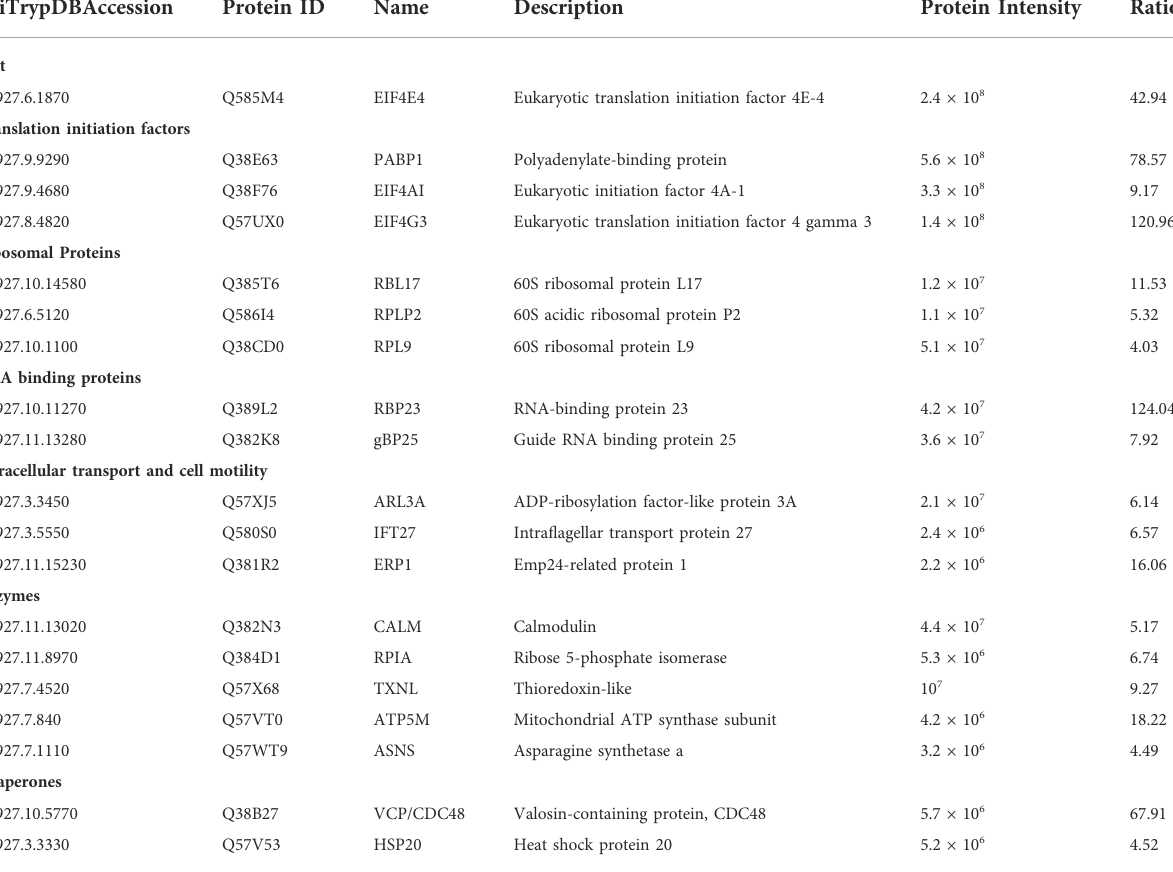
TABLE 3 Most enriched proteins co-precipitated with the eYFP-tagged EIF4E4 in Trypanosoma brucei procyclic cells.